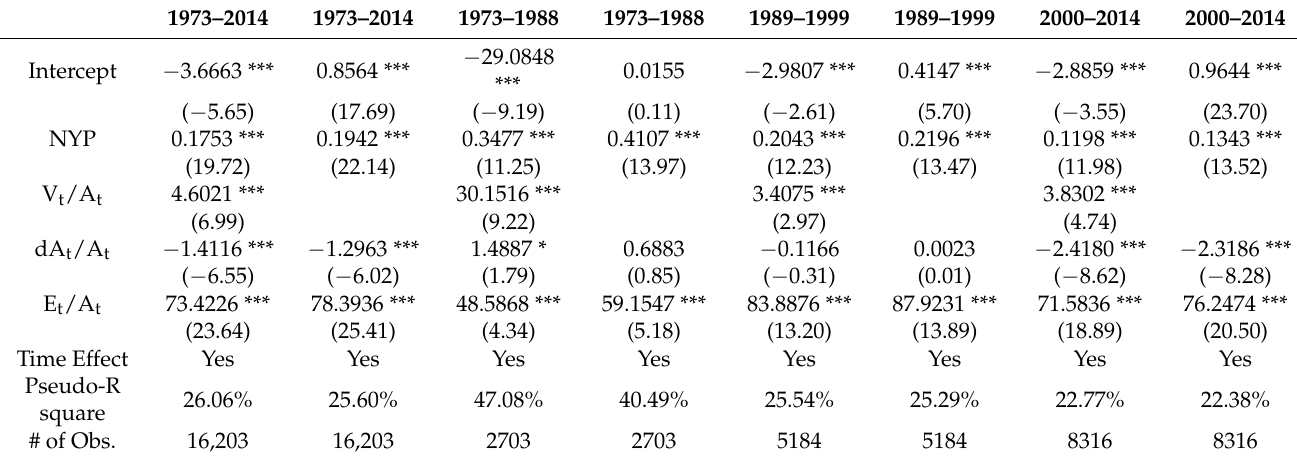
Table 3. Baseline logit regressions. This table provides results of logit regressions of the determinants of the likelihood a bank will pay dividends. The dependent variable equals one in year t if the bank pays dividends in year t and zero otherwise. The independent variables are profitability (Et/At), the growth rate of assets (dAt/At), NYP is the percentile of market capitalization in NYSE (New York Stock Exchange) firms, and the market-to-book ratio (Vt/At). T-statistics are reported in the parentheses. ***, **, and * indicate statistical significance at the 1%, 5%, and 10% level,